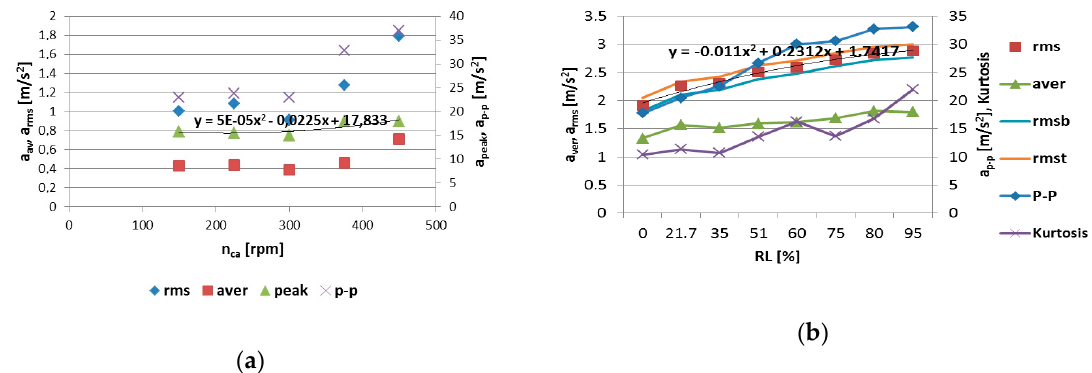
Figure 6. The influence of rotational speed of camshaft n ca on values of amplitude estimates of acceleration vibration signal on the injector valve for fuel setting 58% along with an approximation line for the polynomial model ( a ); ( b ) the effect of engine load on the amplitude measures of vibration acceleration signals received in the injection subsystem along with an example error field: aver —average value, peak—crest value, p-p —peak to peak value, rms —root-mean-square value, rmsb — lower borderline , rmst —upper borderline, RL —relative load.